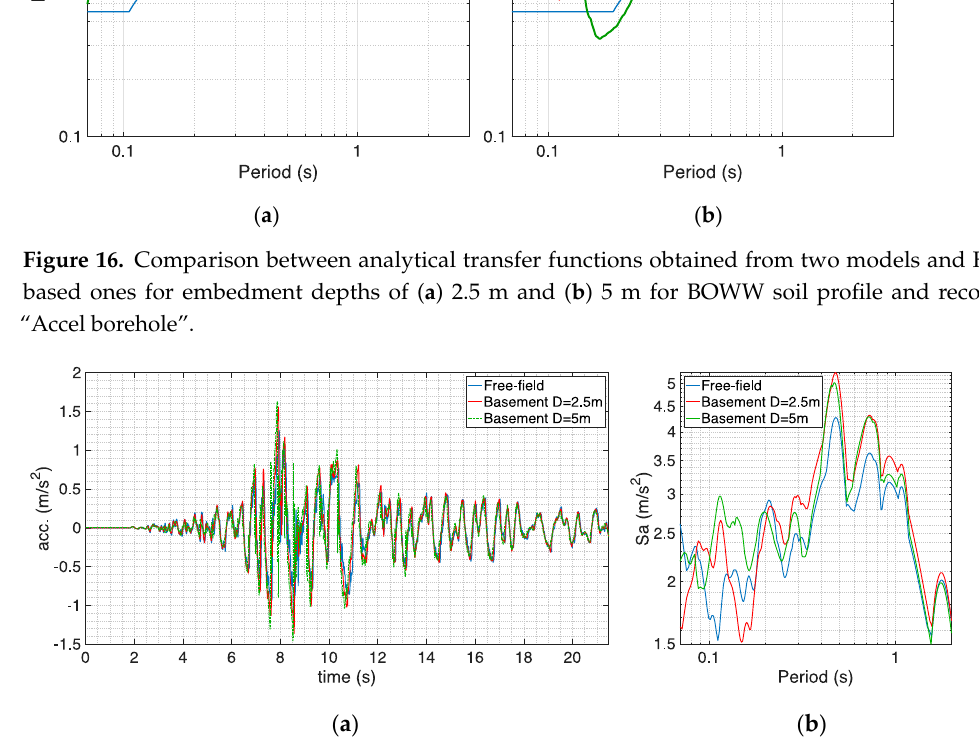
Figure 16. Comparison between analytical transfer functions obtained from two models and FE- based ones for embedment depths of ( a ) 2.5 m and ( b ) 5 m for BOWW soil profile and record “Accel borehole”.